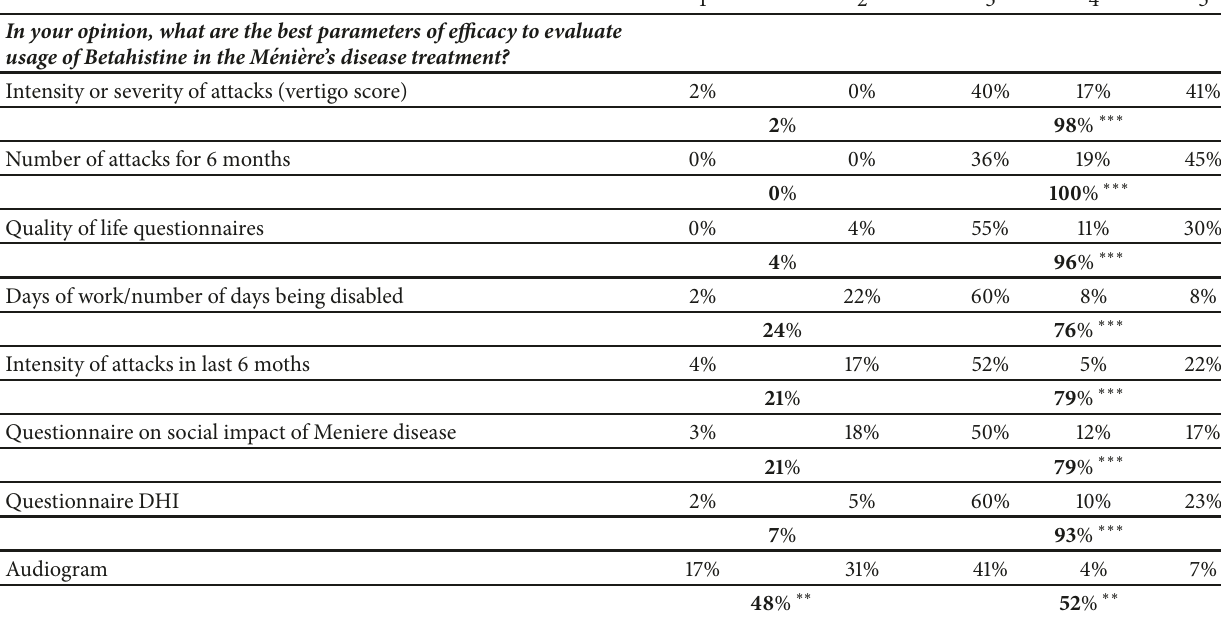
Table 9: Results of the Consensus Conference on the parameters to be used to evaluate betahistine efficacy. 1 = absolutely disagree, 2 = disagree, 3 = agree, 4 = more than agree, and 5 = absolutely agree. Consensus was reached when the sum of items 1 and 2 or 3, 4, and 5 reached 66%. Same asterisk